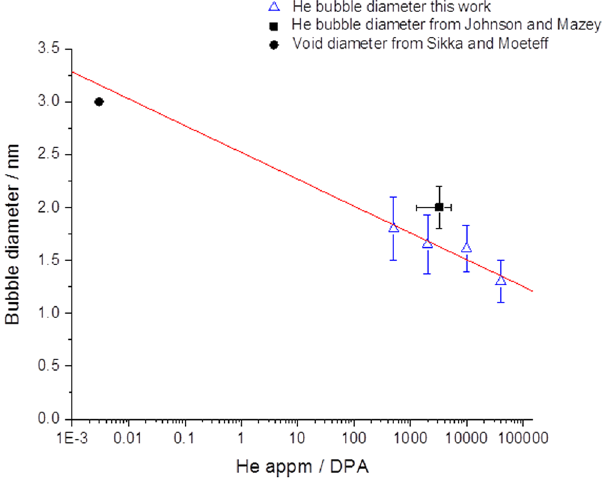
Figure 4. He bubble diameter in He ion-irradiated W samples as a function of the log of the He-appm ratio with previous work on He ion irradiation 8 and void diameters from neutron-irradiated W 12 . (Line of best fit shows linear fit of data reported in this work